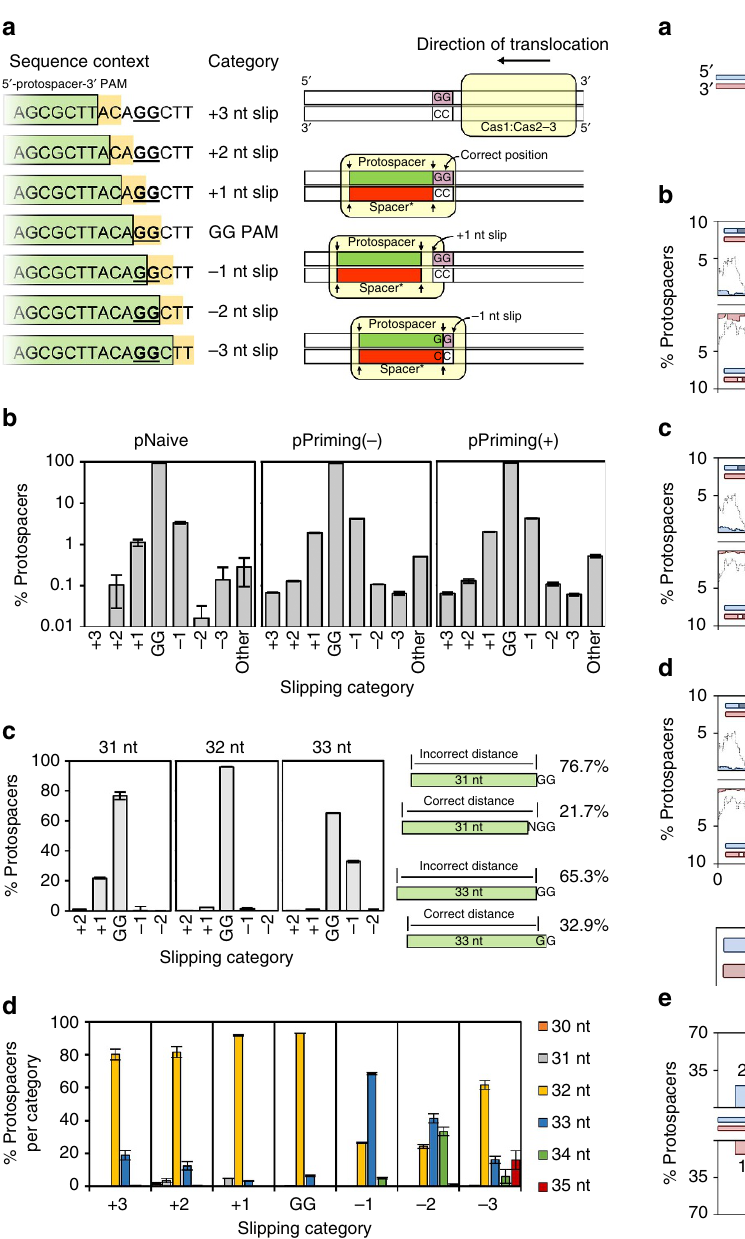
Figure 4 | Protospacer mapping. ( a ) Schematic of the experimental setup for initiating spacer acquisition, showing the plus (blue) and minus strand (red) with or without the PPS (dark blue or red, depending on the strand) and PAM (white). The protospacer locations were mapped on ( b ) pNaive, ( c ) pPriming( (cid:2) ) or ( d ) pPriming( þ ) using a sliding 150nt binning window. Protospacers on the plus and minus strand are indicated in blue and red respectively. The dotted grey graph in the background depicts the PAM-distribution, which is the density of PAM sequences across the plasmid using a sliding 150nt binning window. The position of the PPS in pPriming( (cid:2) ) and pPriming( þ ) is indicated with a vertical dashed line and a dark red or blue arrow, respectively. Genes (green) and other features (yellow) on the plasmids are schematically depicted between the plus and minus graphs. T ¼ oriT (origin of transfer), V ¼ oriV (origin of replication). ( e ) Proportion of newly targeted protospacers 5 0 and 3 0 of the PPS on each strand. For pNaive this is centred relative to the PPS in the pPriming plasmids. Error bars represent the s.e. of the